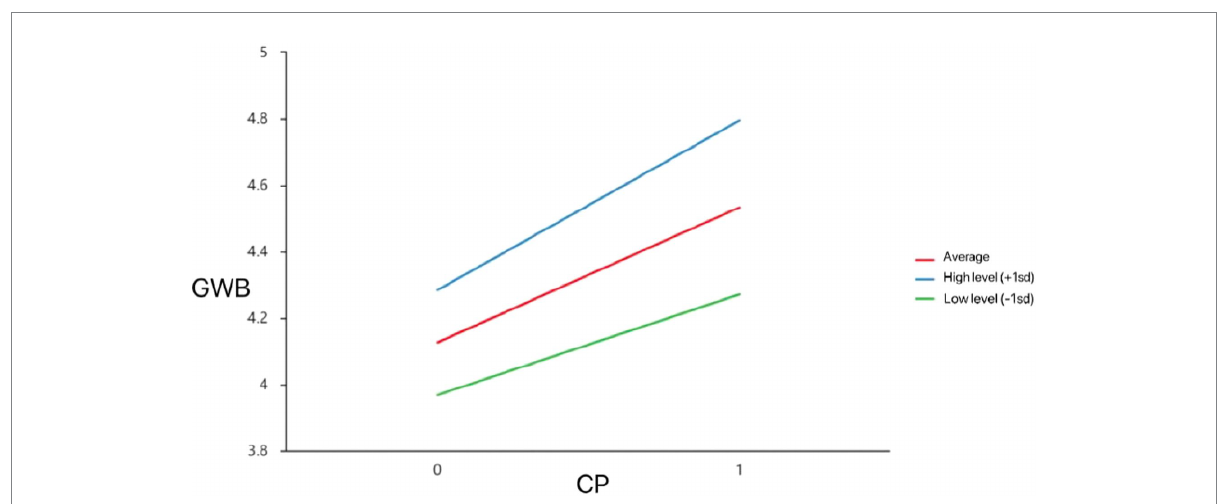
FIGURE 5 Model of test for simple slopes showing moderating influence of SS on association between CP and GWB.